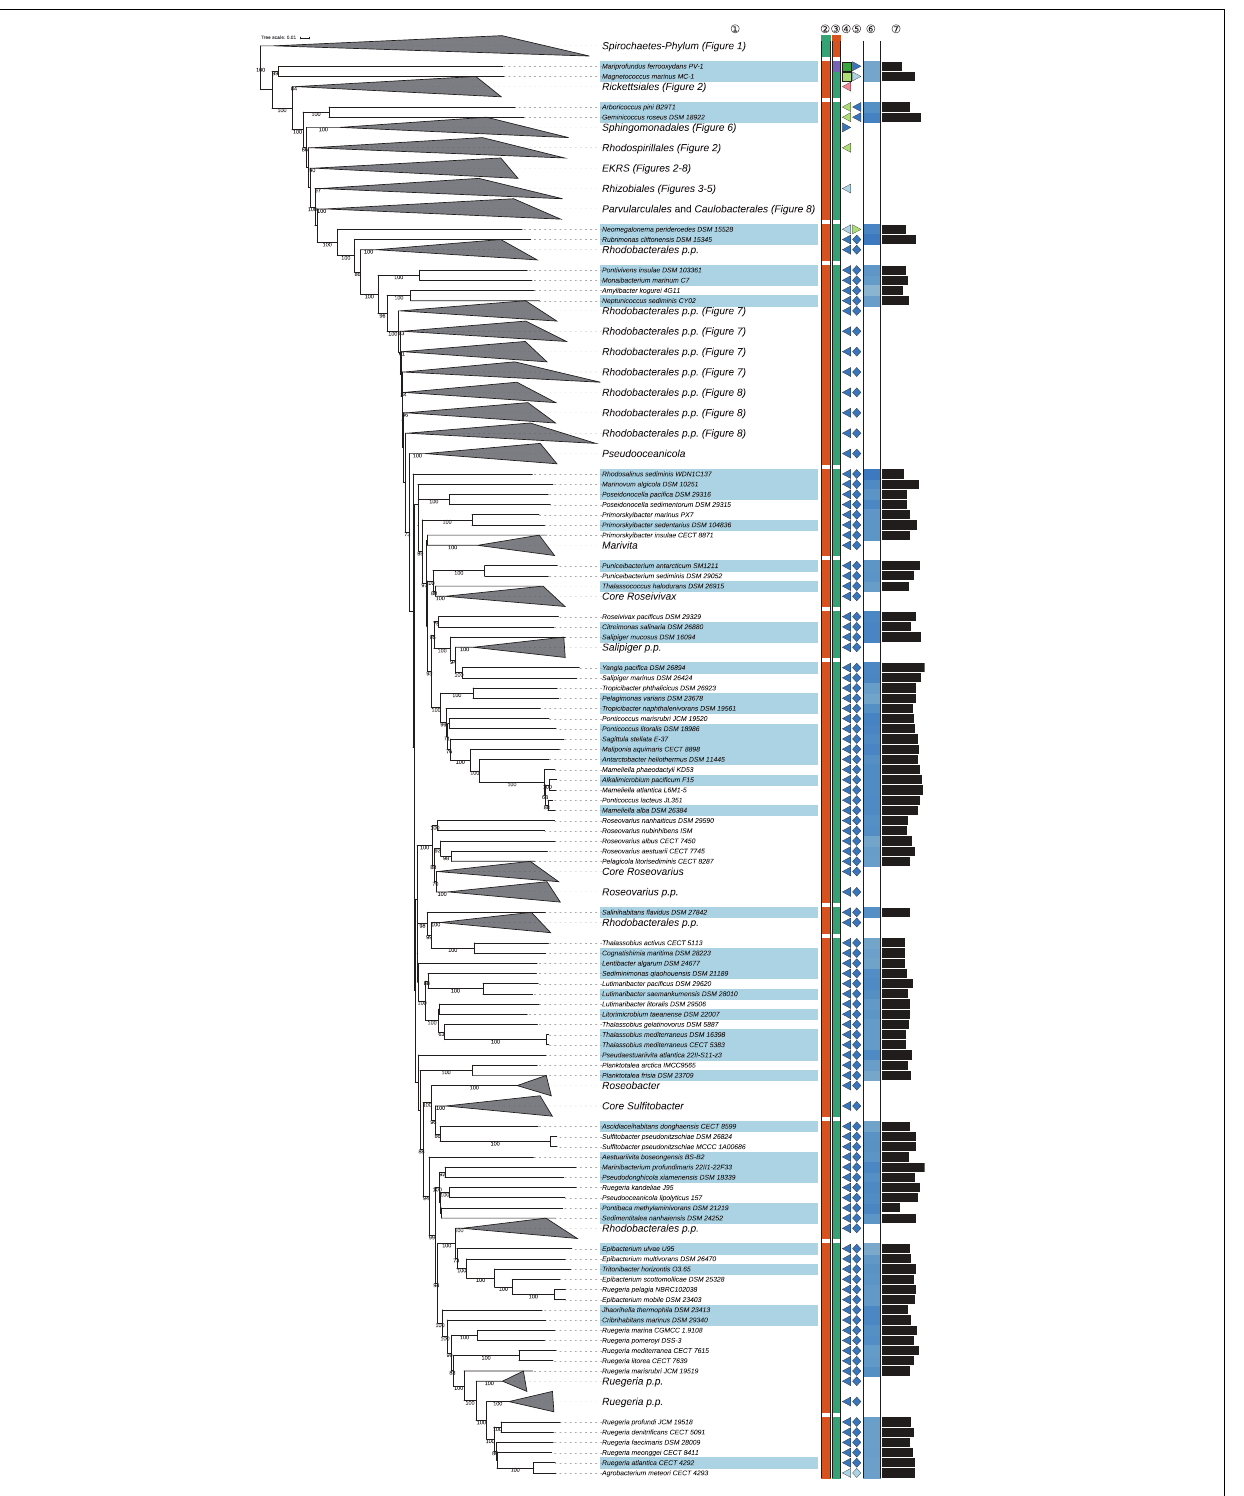
FIGURE 9 | Eighth part of the GBDP tree shown in Figure 1 , focussing on parts of Rhodobacterales . The clade labeled EKRS comprises the orders Emcibacterales, Kordiimonadales, Rhodothalassiales, and Sneathiellales , details for which are shown in other figures. Tip labels with light-blue background indicate type species of genera, colors and symbols to the right of the tips indicate, from left to right, phylum, class, order, and family; for details and abbreviations see Figure 1 . The blue color gradient indicates the G+C content as calculated from the genome sequences, followed by black bars indicating the (approximate) genome size in base pairs.